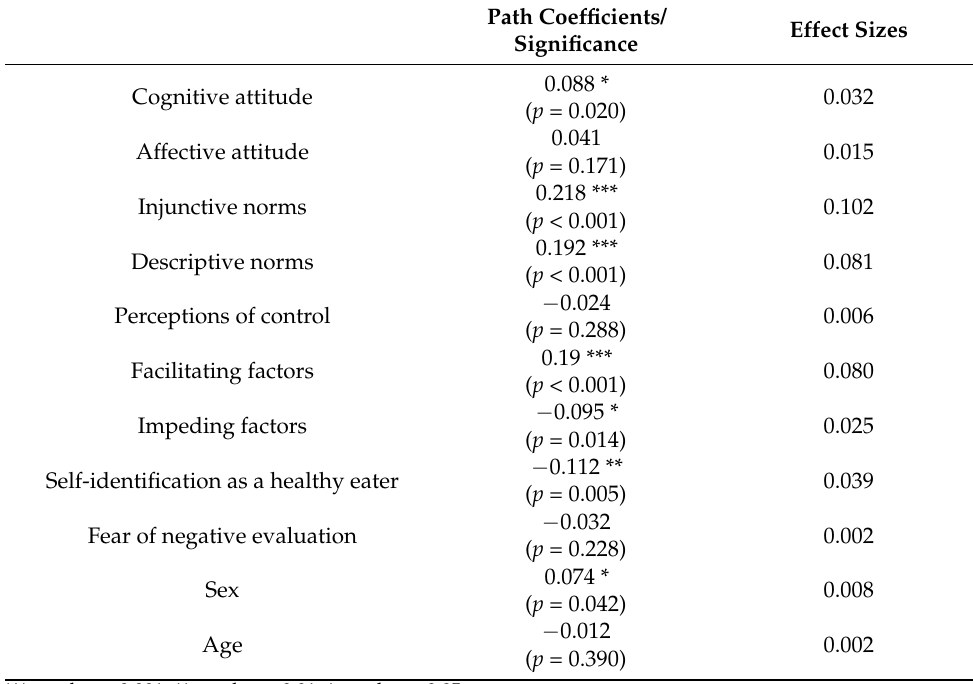
Table 4. Path coefficients and effect sizes, with p -values in